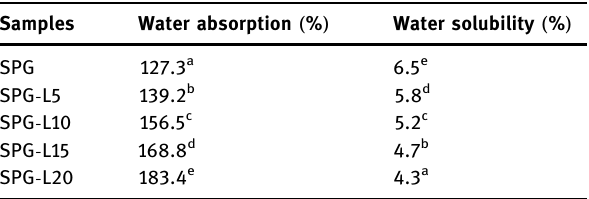
Table 3: The e ff ect of ε - polylysine concentration on the